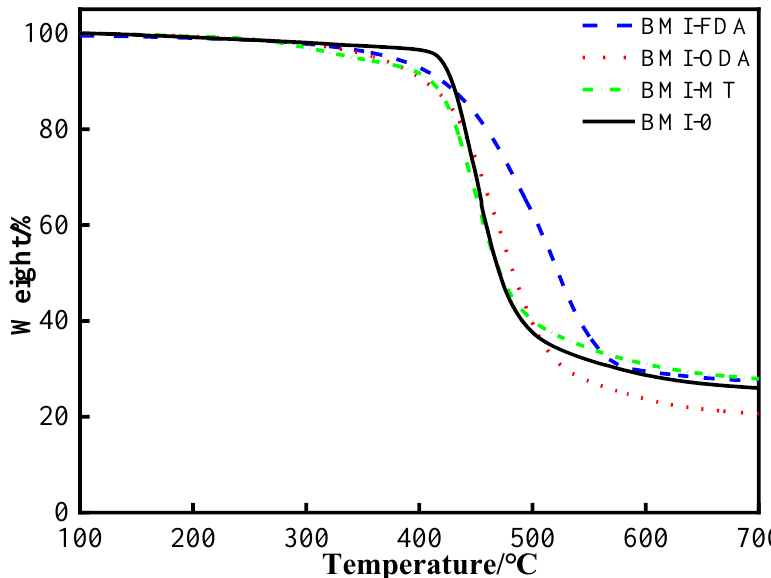
Figure 10. TG curves of BMI-NH 2 .